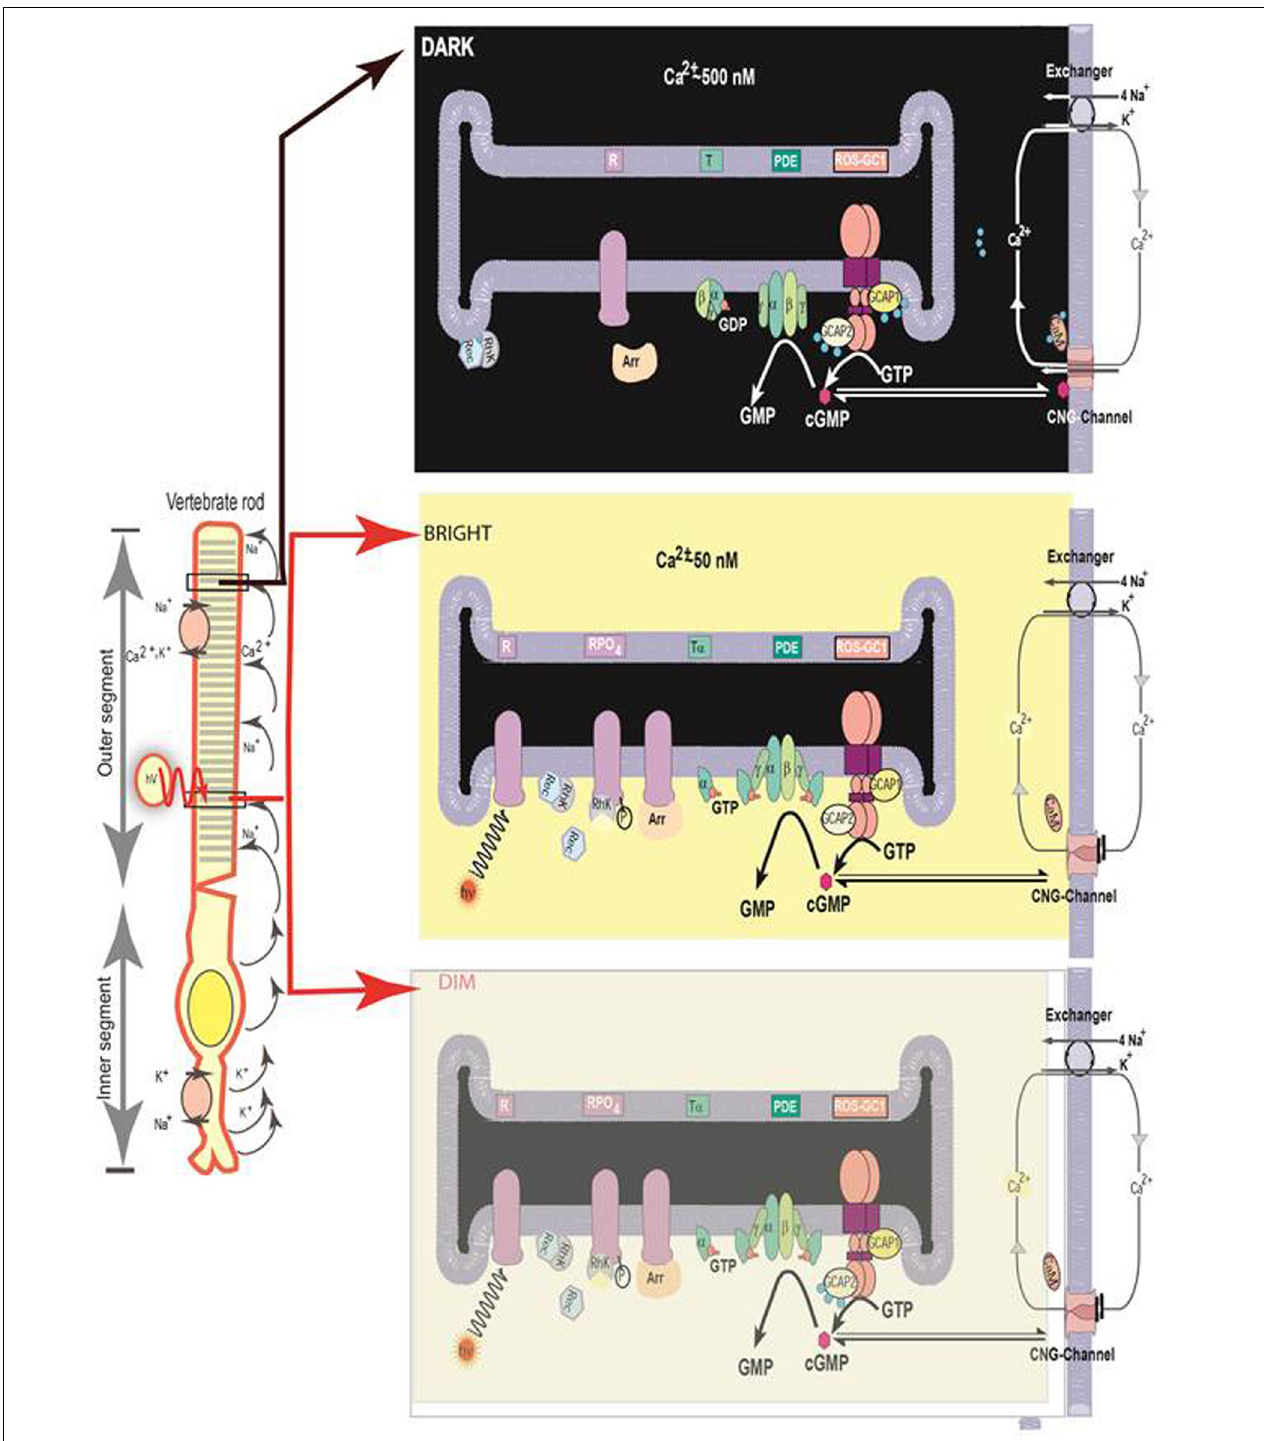
outer segment membrane (see also right panels) maintain the overall ionic gradients against the dark flows. The capture of a photon (h ν ) by a rhodopsin molecule in one of the disc membranes of the outer segment initiates the photo-transduction cascade. Right upper panel. DARK. The components of the Photo-Transduction cascade are shown in the dark/resting steady-state. Cytoplasmic cyclic GMP, generated by the basal catalytic activity of ROS-GC,